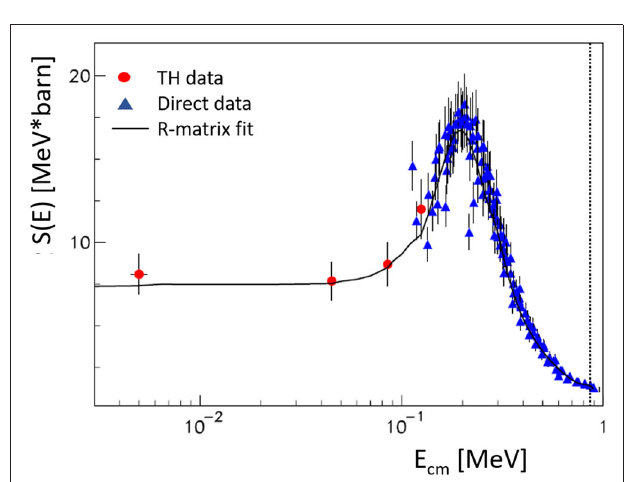
FIGURE 4 | Bare nucleus S(E)-factor for the 7 Li(p, α ) 4 He reaction obtained with direct data (blue triangles) and with the THM (red dots) taken from Lamia et al. (2012b). The solid line is an R-matrix fit to the overall direct and indirect data sets as discussed in the text. The figure is adapted from Pizzone et al. (2014).